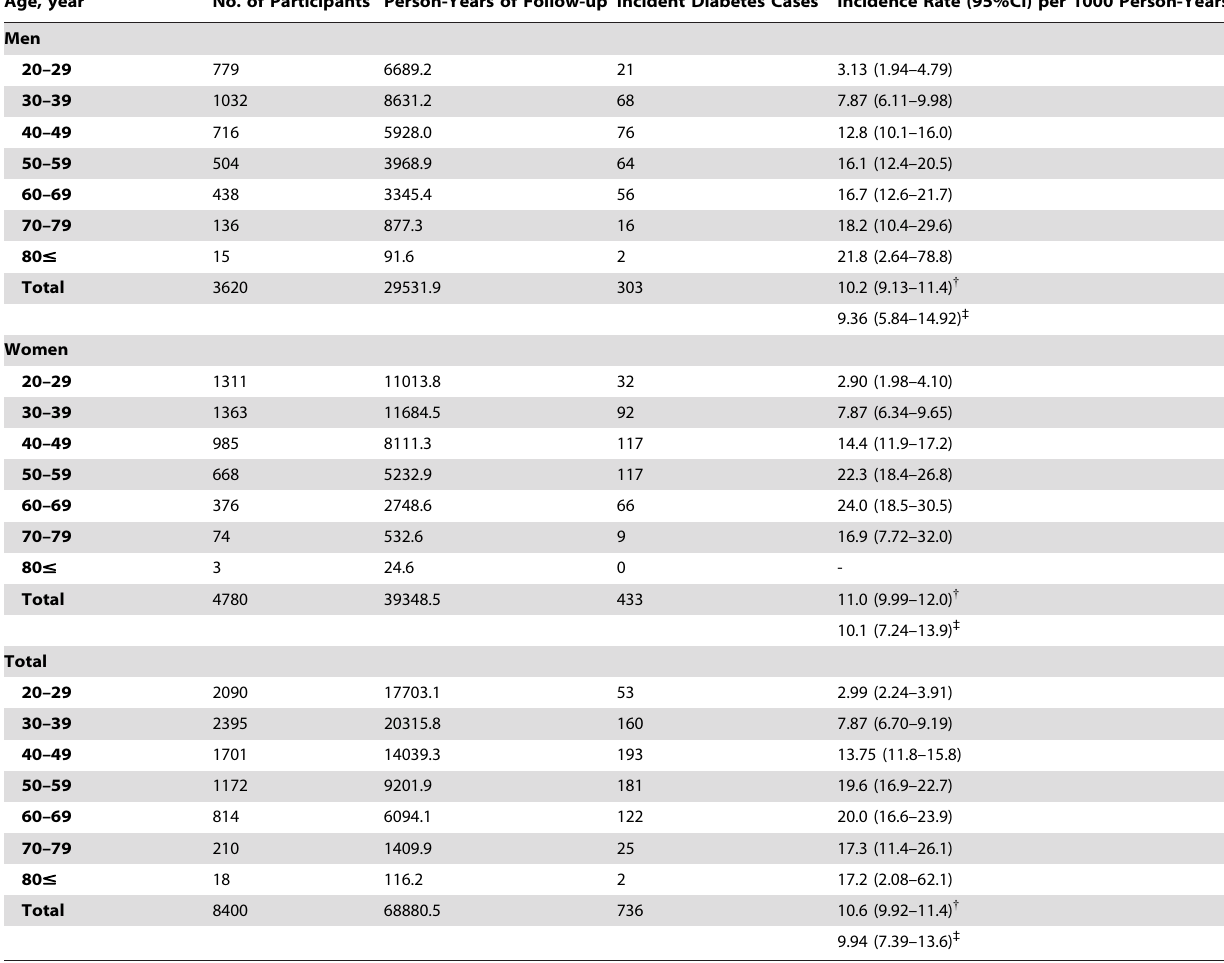
Table 2. Diabetes Incidence per 1000 Person-Years by Age and Gender. Tehran Lipid and Glucose study